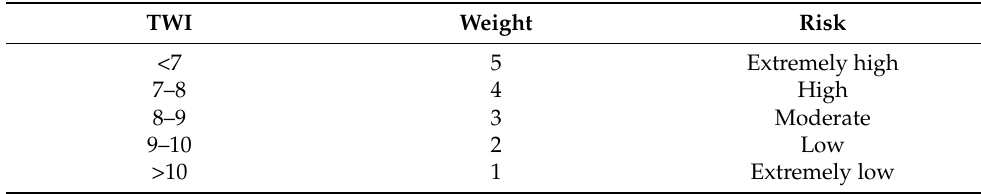
Figure 6. The base map of TWI in Laoshan. Each level is determined by the fire risk classification. Table 5. Fire risk classification of